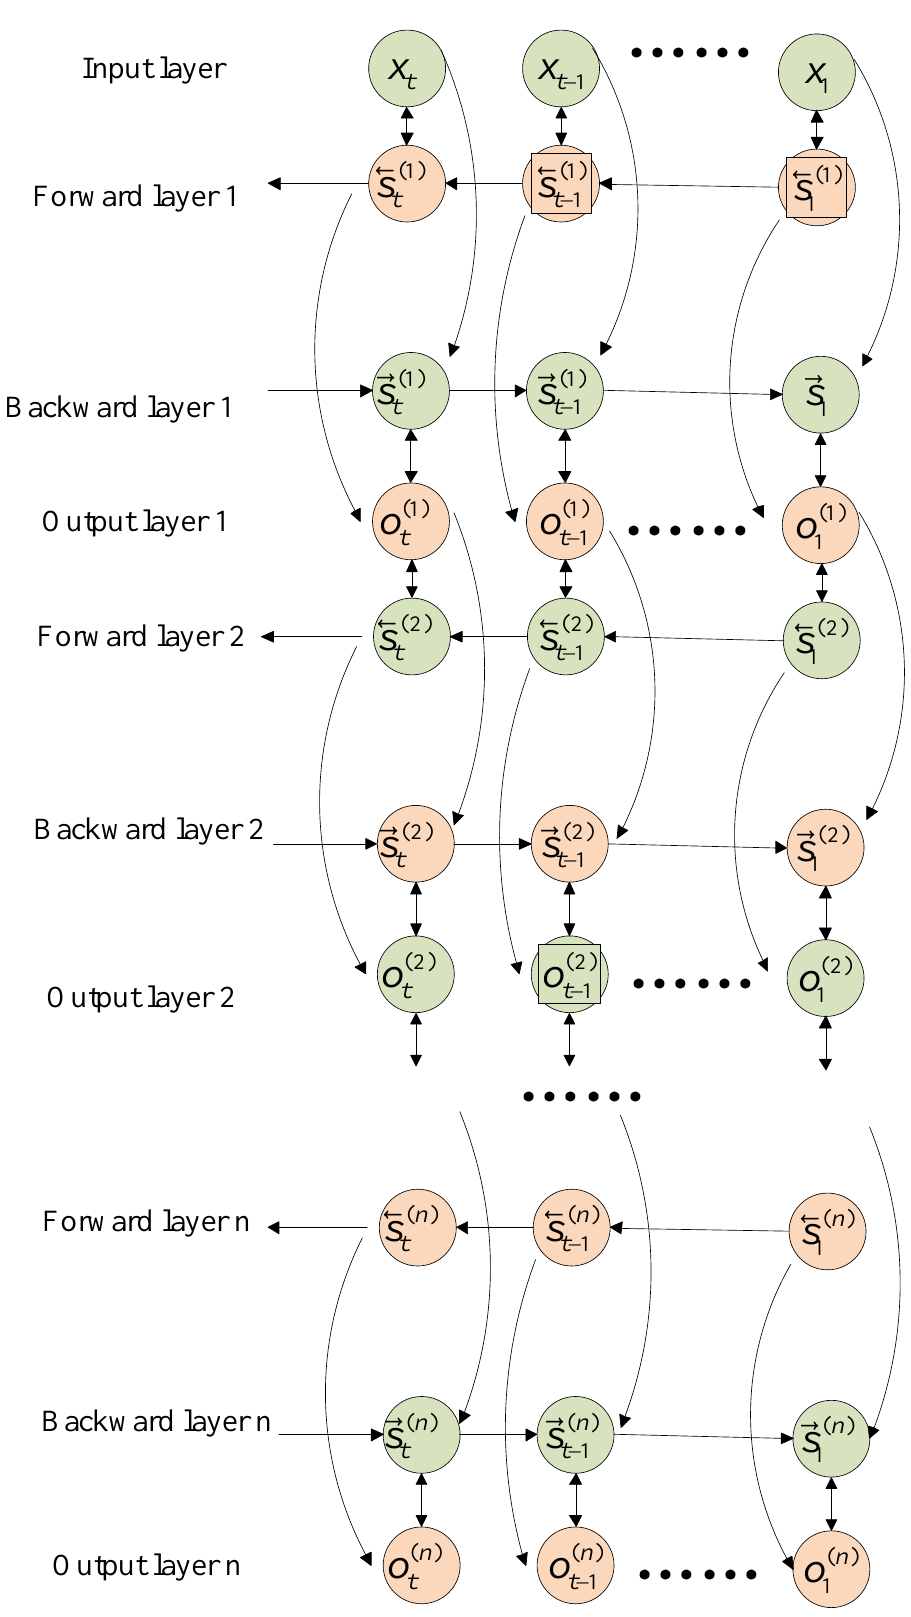
Figure 4. Multi-layer stacked bidirectional LSTM neural network. Figure 4 specifies the multi-layer bidirectional LSTM neural network system struc- ture; the output of the multi-layer stacked bidirectional LSTM neural network is deter- mined by the forward and backward results of each layer, and its model can be expressed as follows.